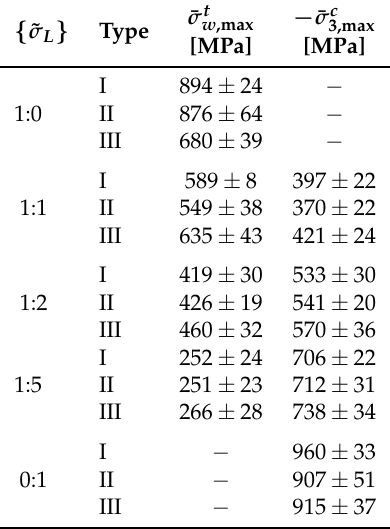
Table A2. Mean values and standard deviation of σ t w / σ c uniaxial